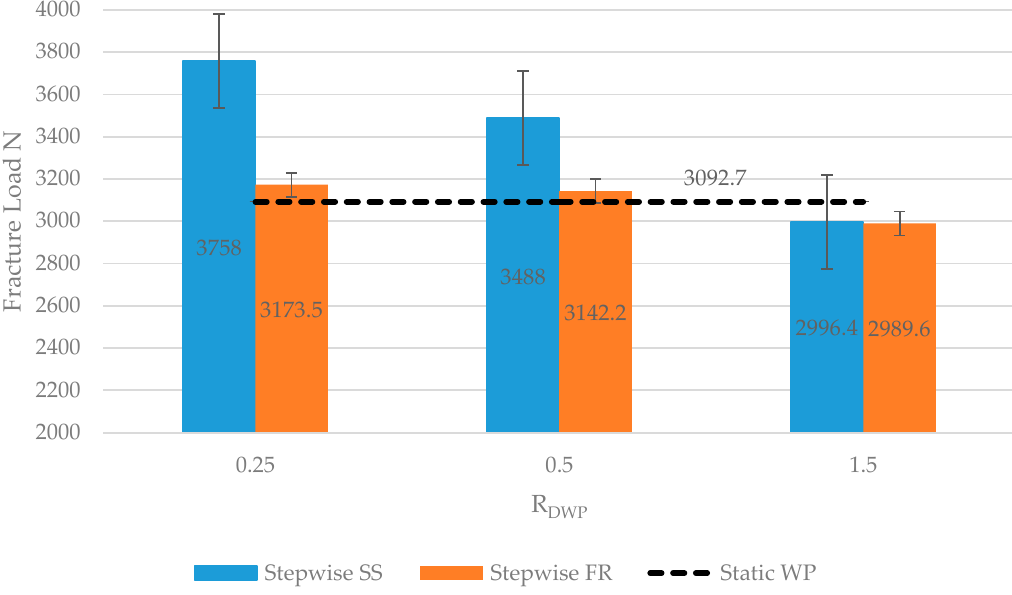
Figure 7. Comparison of the tensile strength results for DWP and static welding parameter ( SWP ) .